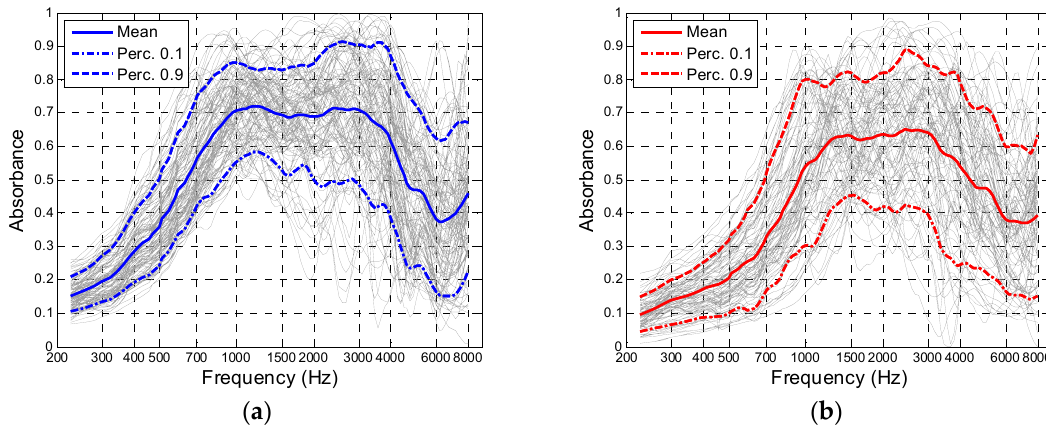
Figure 4. Absorbance peak-pressure against frequency for the Normal group ( a ) and Otosclerotic group ( b ). Solid lines mark the mean values and dotted lines mark the 10th and 90th percentiles.